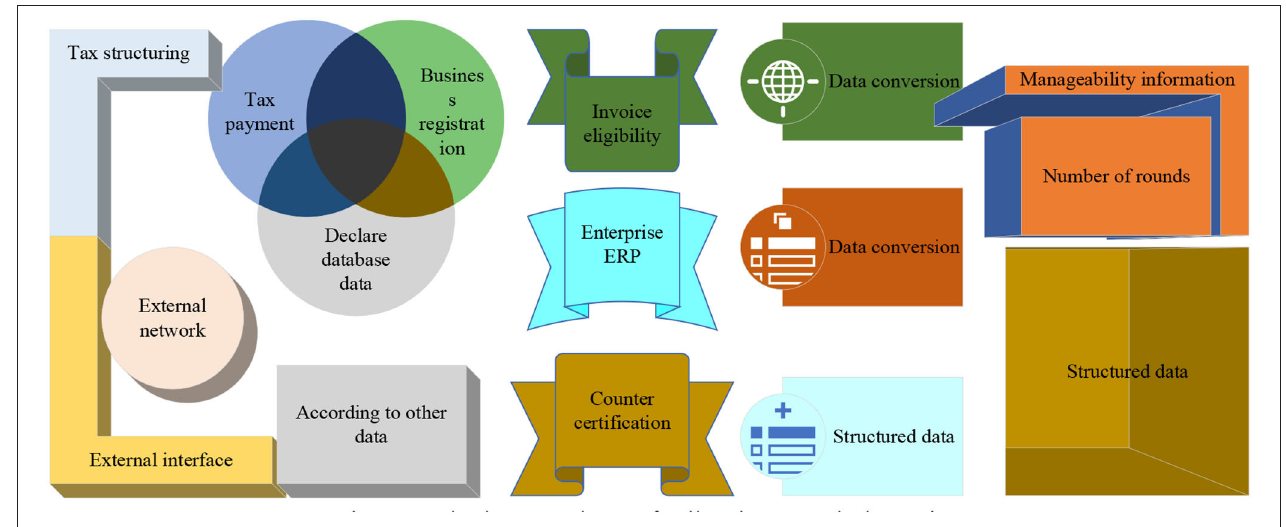
FIGURE 2 | Big data warehouse for listed companies’